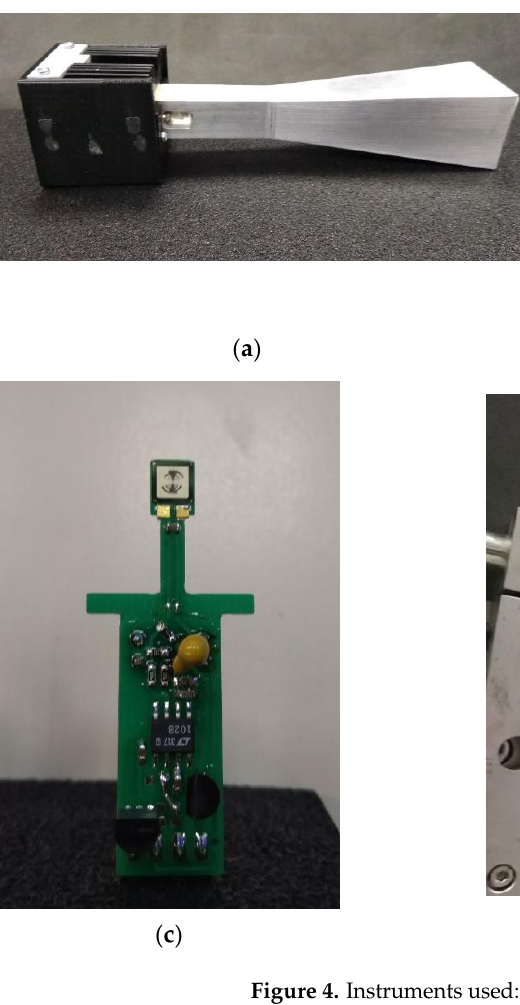
Figure 4. Instruments used: ( a ) AM-THz source with Gunn diode and attached horn antenna, ( b ) AM-THz source and lens holder, ( c ) Sensor PCB, and ( d ) Sensor PCB holder with linear motor.